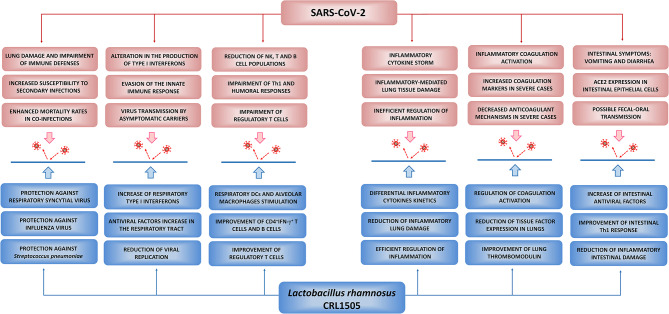
Potential beneficial effects of Lactobacillus rhamnosus CRL1505 against SARS-CoV-2 infection. Proposed potential benefits in the reduction of the incidence and severity of COVID-19 induced by nutritional interventions with the immunobiotic strain L. rhamnosus CRL1505. The principal pathological and immunological alterations during SARS-CoV-2 infection were summarized from Jamilloux et al. (2020), Tay et al. (2020), Merad and Martin (2020), and Chen N. et al. (2020). The beneficial effects of L. rhamnosus CRL1505 in the respiratory tract were summarized from Villena et al. (2012a), Chiba et al. (2013), and Zelaya et al. (2014). The beneficial effects of L. rhamnosus CRL1505 in the intestinal tract were summarized from Villena et al. (2014), Tada et al. (2016), and Albarracin et al. (2017, 2020).